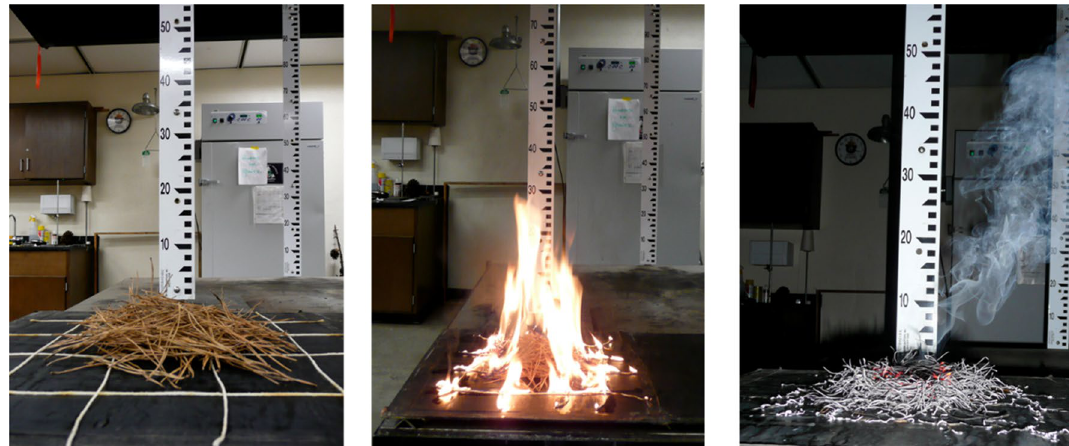
Figure 7. An example of pine litter flammability experiment (here, Pinus glabra ) from pre-ignition (left), during flaming (middle), and smoldering